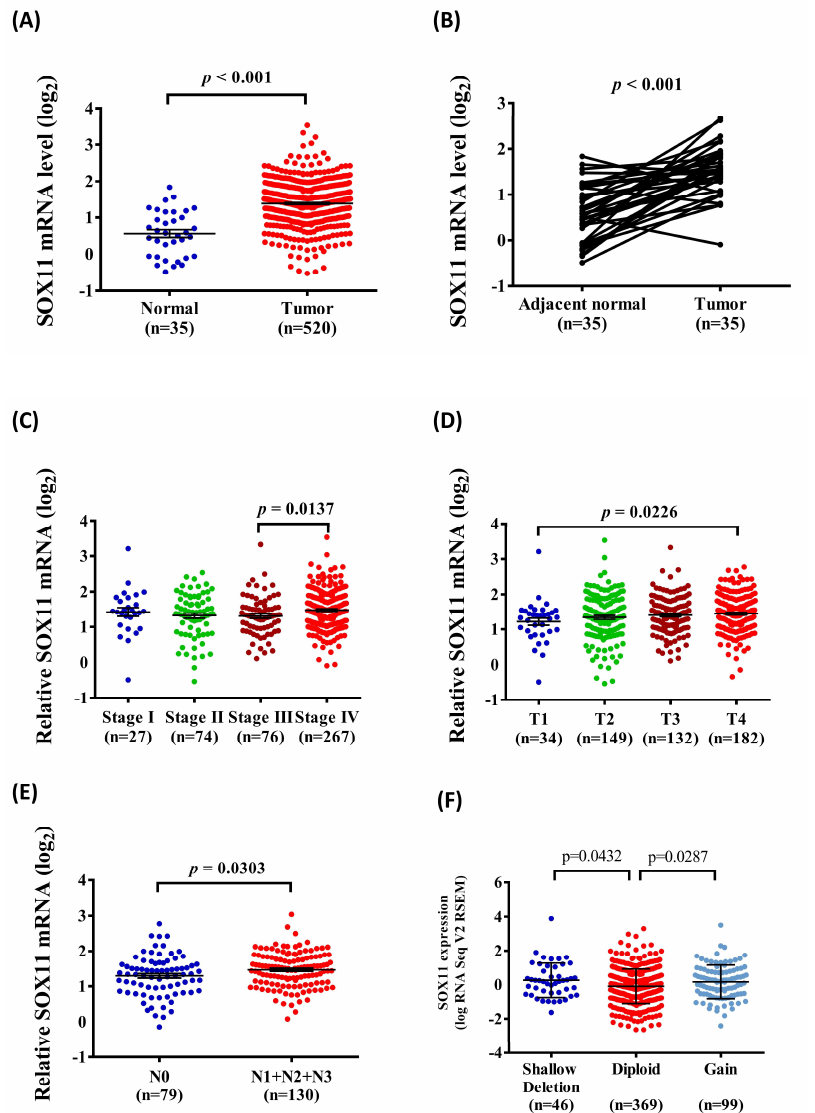
Figure 1. Association of SOX11 mRNA level and clinical status from the TCGA database. ( A ) The SOX11 mRNA level of HNSCC tissues were compared to normal tissues. ( B ) The SOX11 mRNA level were compared according to adjacent normal tissues and HNSCC tissues. ( C ) The SOX11 mRNA levels were compared according to tumor stage. ( D ) The SOX11 mRNA levels were compared according to tumor clinical T stage. ( E ) The SOX11 mRNA levels were compared according to clinical n stage. ( F ) Boxplots of RNA-Seq for SOX11 mRNA demonstrating significantly altered expression in diploid versus deletion and gain cancers.